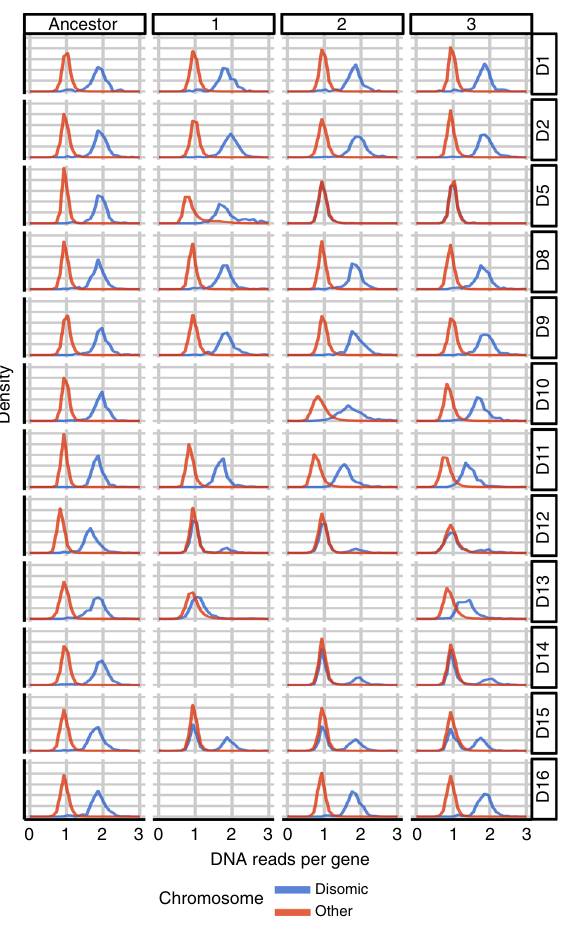
Fig. 2 Karyotype of evolved disomic lines. The plot shows the distribution of genomic read density per gene. Values are normalized per sample by the total number of mapped reads, and per gene to the WT value. Genes were split in two groups, separating those located on the disomic chromosome (chromosome I for D1, chromosome II for D2, etc.; shown in blue) from the rest (red). This representation allows to readily identify losses of the extra chromosome (e.g. complete losses in D5 lines 2 and 3). A more detailed read density heat map is shown in Supplementary Fig.